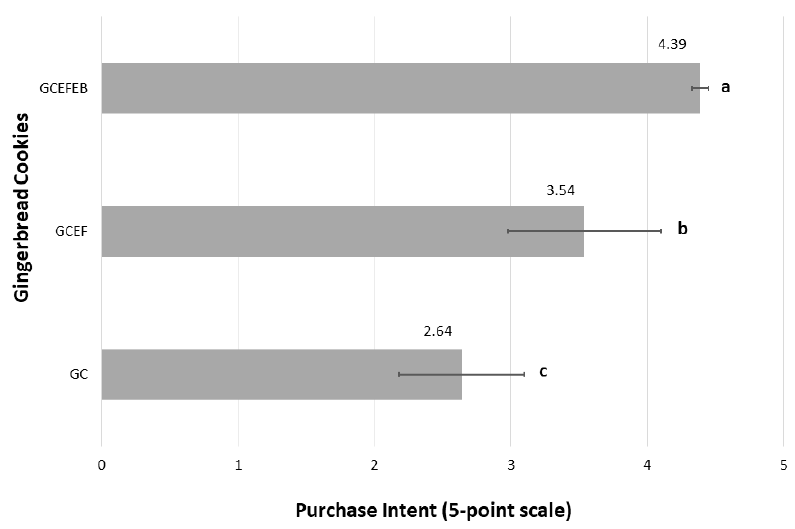
Figure 3. Average ratings of purchase intent of gingerbread cookies covered in chocolate without additives (GC), and with elderflower dry extract (GCEF), as well as enriched with elderberry juice concentrate (GCEFEB). Purchase intent was based on the 5-point scale (1 = certainly would not buy, 2 = probably would not buy, 3 = might or might not buy, 4 = probably would buy, and 5 = certainly would buy). Different letters (a–c) indicate significant differences (one-way ANOVA and Tukey’s test, p ≤ 0.05 ) .